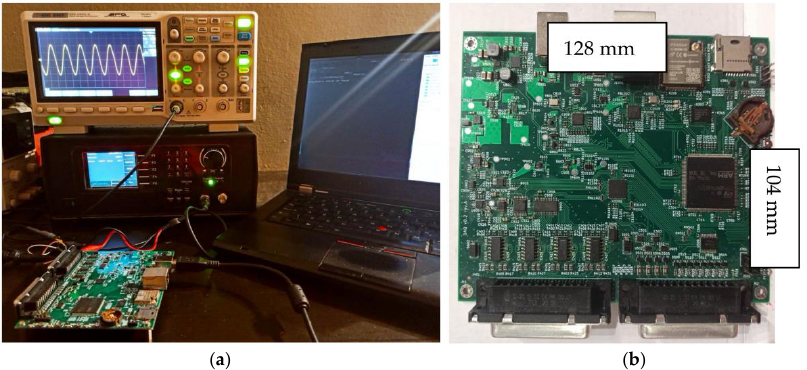
Figure 1 . Measurement station ( a ) and the designed PCB measurement module ( b ) . Figure 1. Measurement station ( a ) and the designed PCB measurement module ( b